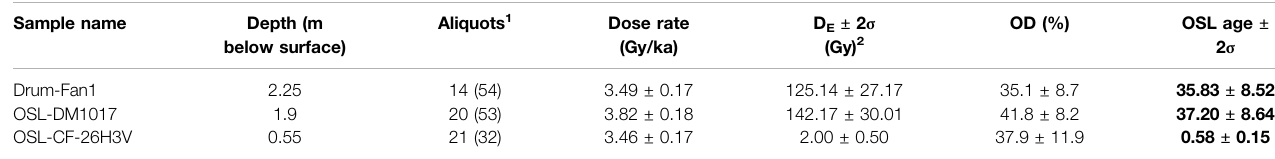
TABLE 3 | OSL fi eld, laboratory, and fi nal age information.